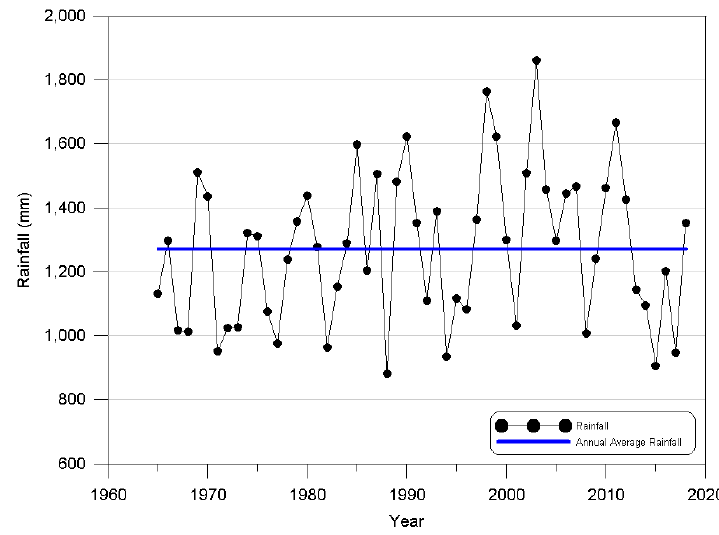
Figure 4. Rainfall trend by year (1965–2018).